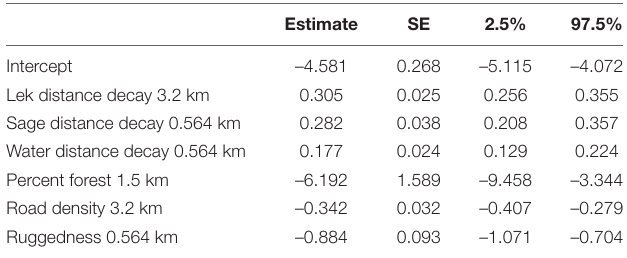
TABLE 5 | Standardized coefficient estimates and profile likelihood 95% confidence intervals for top winter resource selection function model.